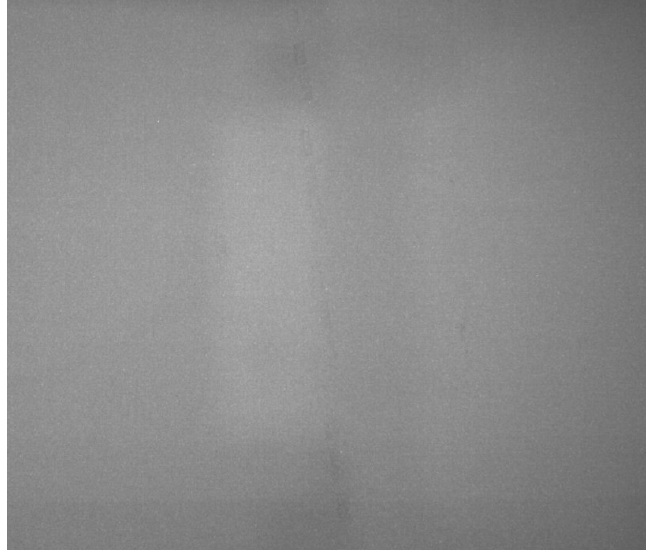
Figure 6. The powder-bed image of layer 20 before laser